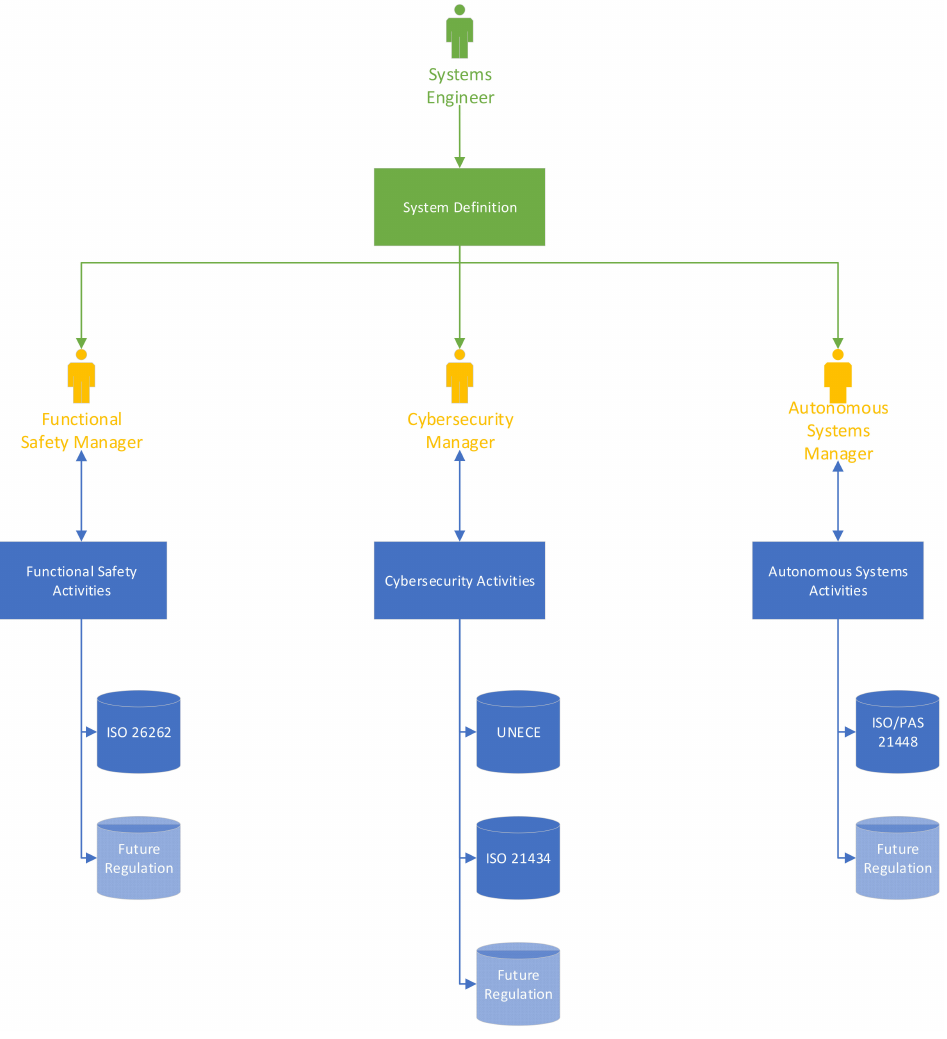
Figure 9. Current flow of information during the design of an